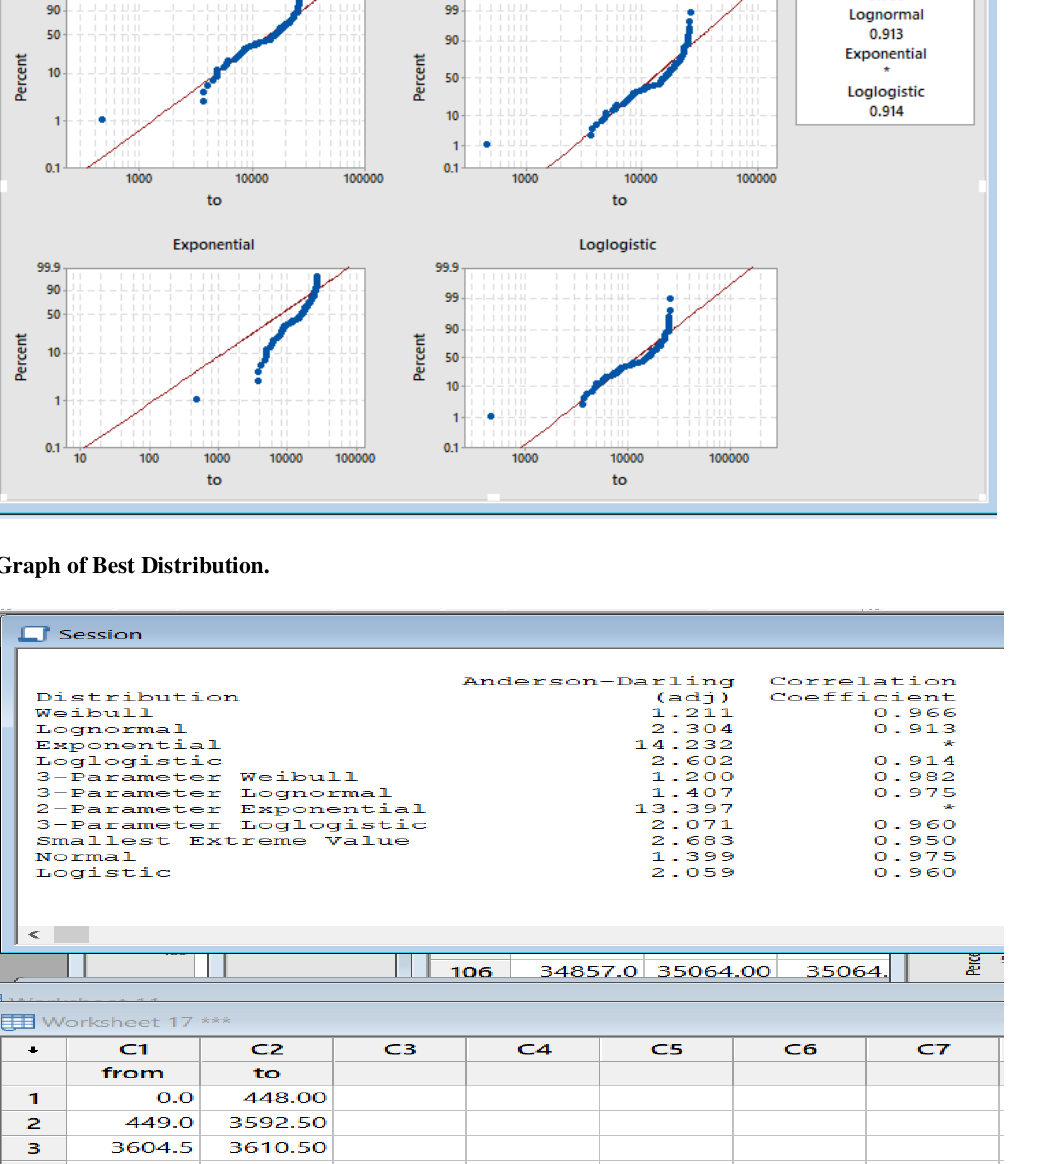
Fig. 5. Anderson-Darling and Correlation Coefficient